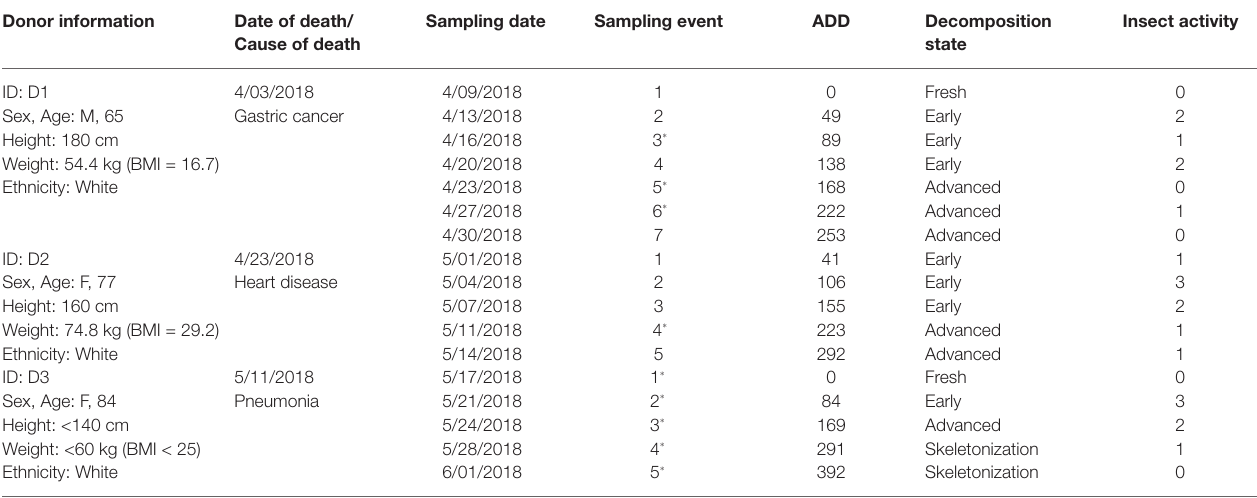
TABLE 1 | Information and sampling schedule for three human donors undergoing decomposition at the Forensic Osteology Research Station (FOREST) facility in Cullowhee, NC. Donor